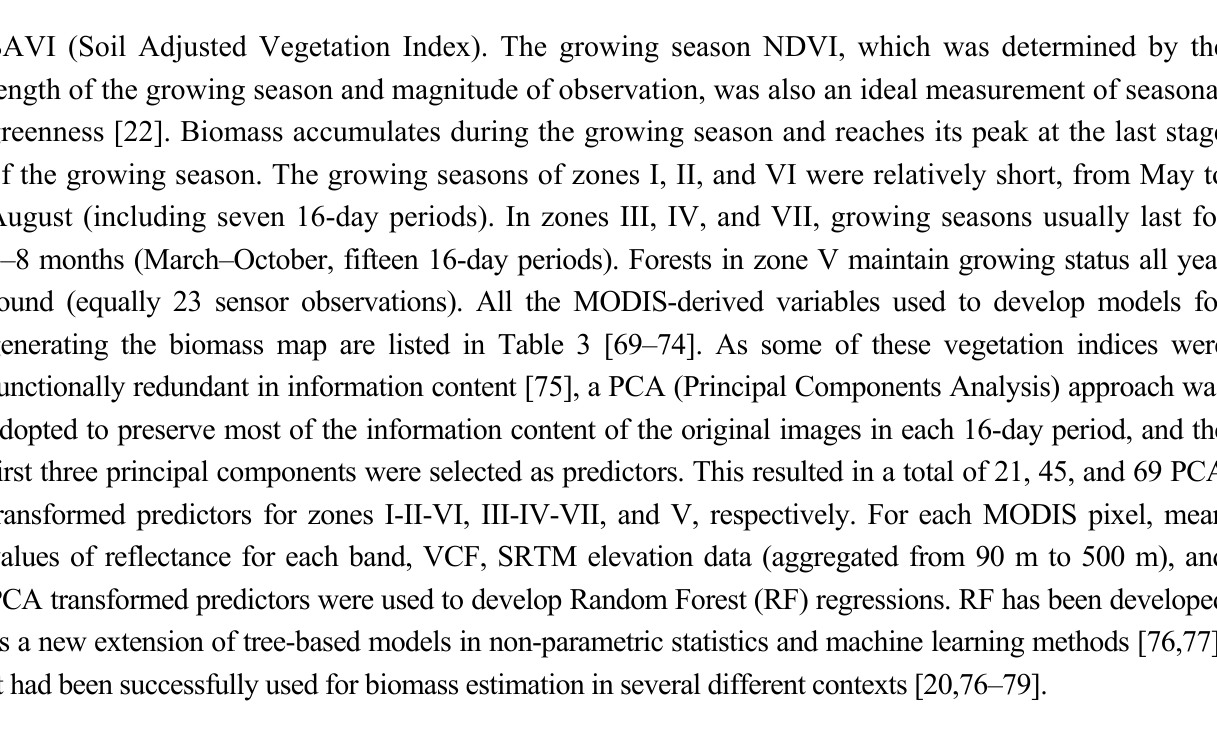
Table 3. Vegetation indices derived from MODIS (Moderate Resolution Imaging Spectro-radiometer)